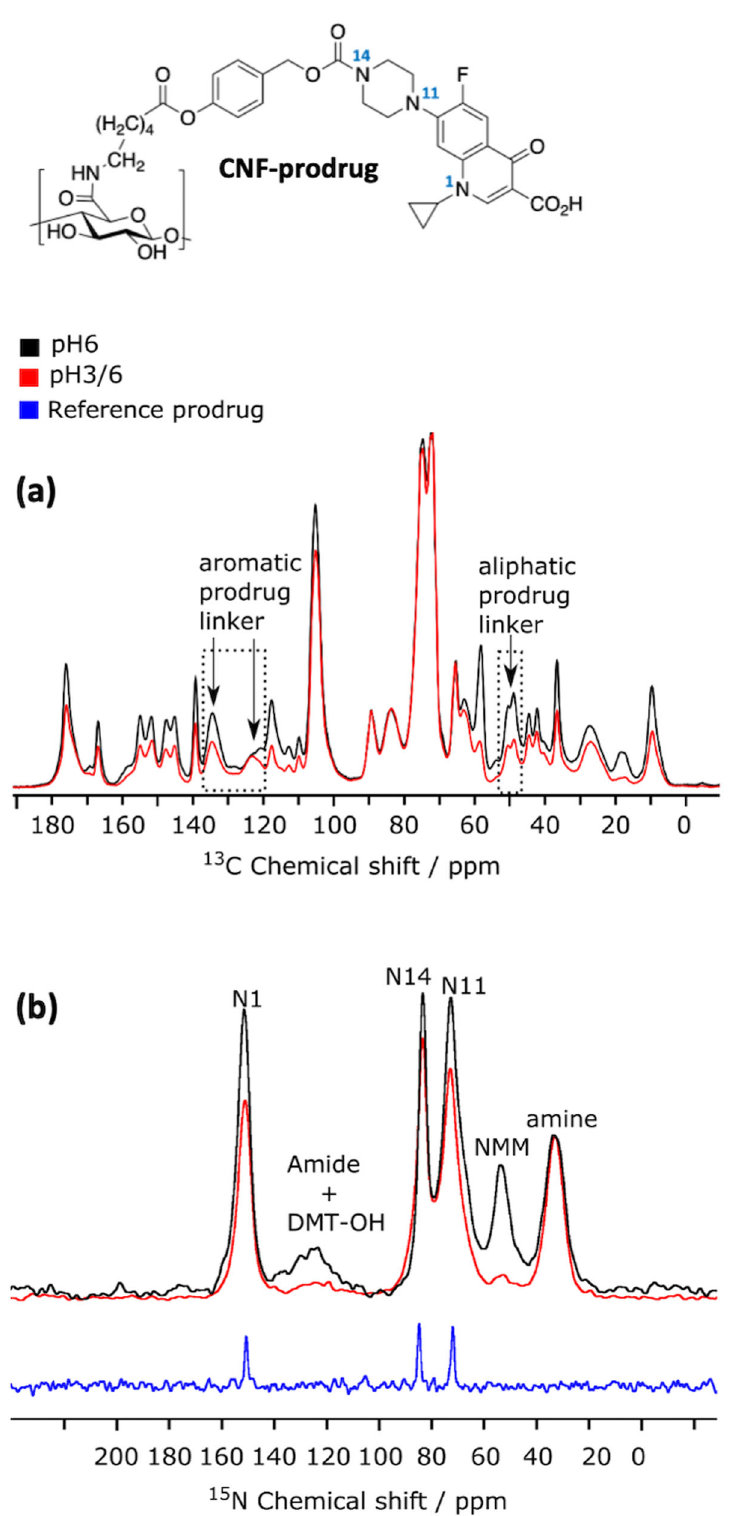
Fig. 6 DNP-enhanced 13 C and 15 N-CPMAS spectroscopy. a DNP-enhanced quantitative 13 C-CPMAS spectra of CNF-prodrug-pH3/6 (in red) and CNF- prodrug-pH6 (in black), both acquired with the MultiCP pulse sequence 79 . The two spectra were scaled to match the cellulose signals. b DNP-enhanced 15 N-CPMAS spectra of CNF-prodrug-pH3/6 (in red) and CNF-prodrug-pH6 (in black). The 13 C CPMAS spectrum (without DNP) of the Boc-protected cipro (crystalline powder) is given as reference (in blue). Peak assignment based on comparison with the 15 N spectrum of Boc-protected cipro and published data 80,81 is given in the fi gure. The 15 N spectra were scaled such that the N1 peak ratio of the two CNF spectra re fl ects the difference by a factor of 2/3 in prodrug loading between the two samples, as determined in ( a ). The CNF-prodrug chemical structure is given at the top of the fi g. with numbering of the nitrogen